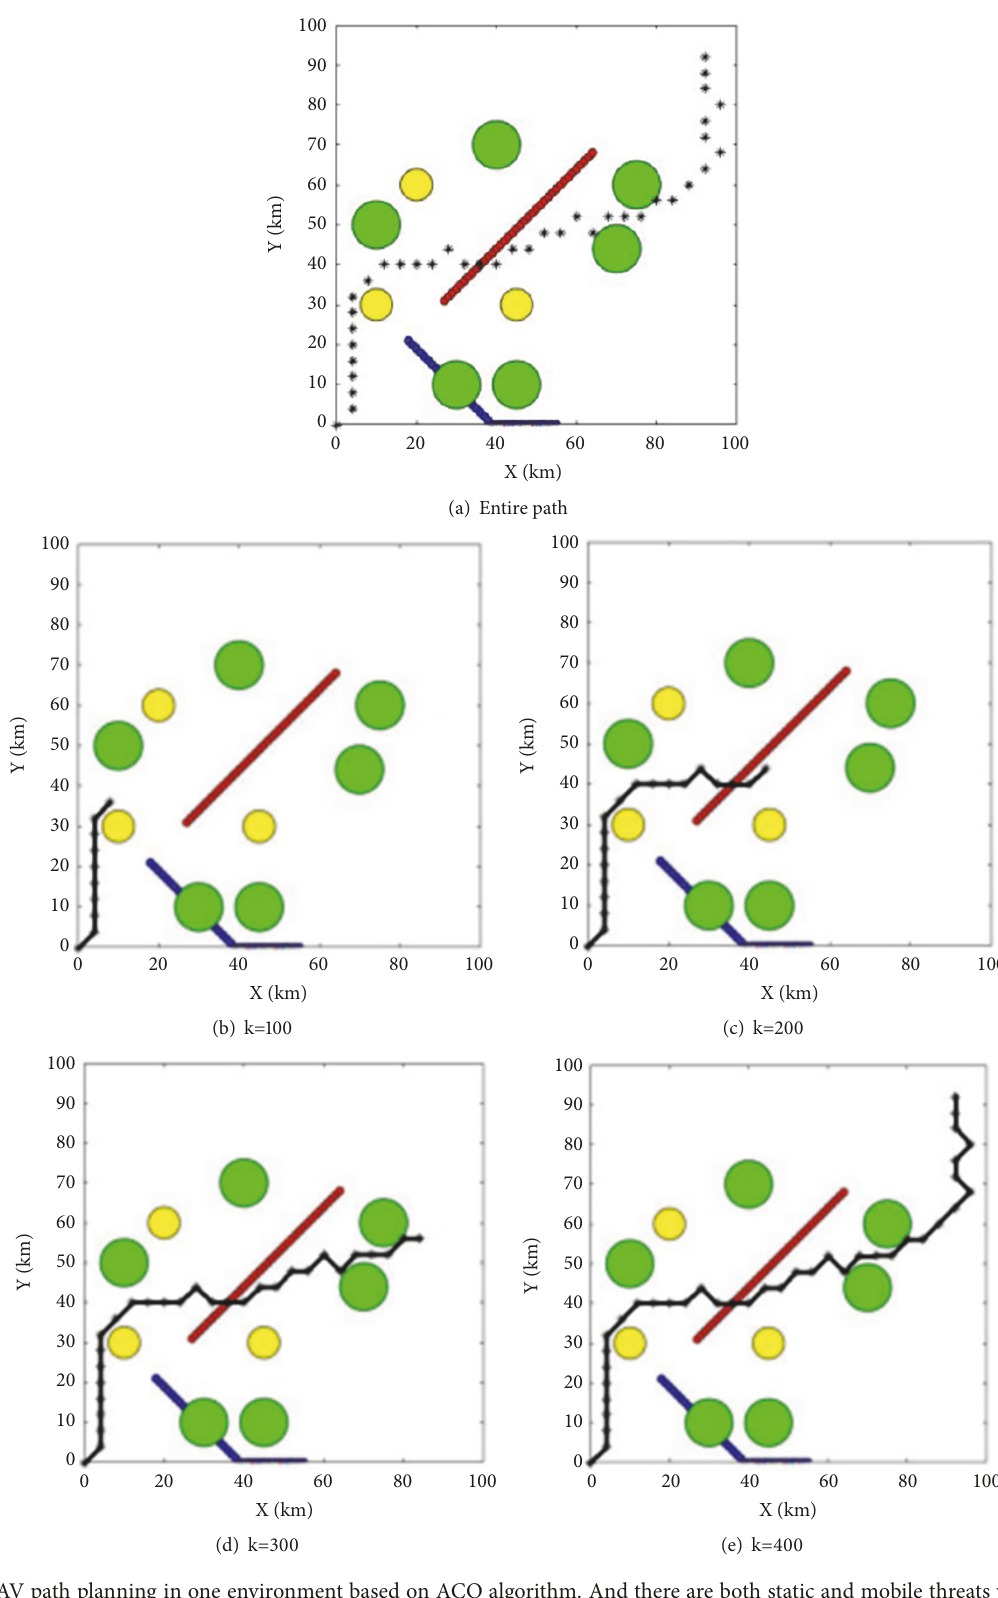
Figure 9: UAV path planning in one environment based on ACO algorithm. And there are both static and mobile threats where (a) is an entire path and (b) to (e) are paths with iterations = 100, 200, 300,